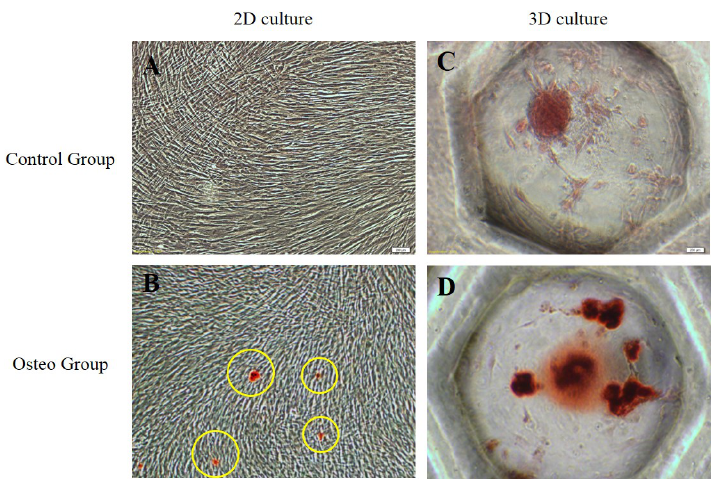
Figure 5. Evaluation of osteogenesis in 2D- and 3D-cultured sPDLSCs (magnification, ×200). ( A ) Control group of 2D-cultured sPDLSCs in basal media. ( B ) Osteo group of 2D-cultured sPDLSCs in osteogenic media. ARS staining revealed significant extracellular calcium deposits (yellow circles). ( C ) Control group of 3D-cultured sPDLSCs in basal media. ( D ) Osteo group of 3D-cultured sPDLSCs in osteogenic media.